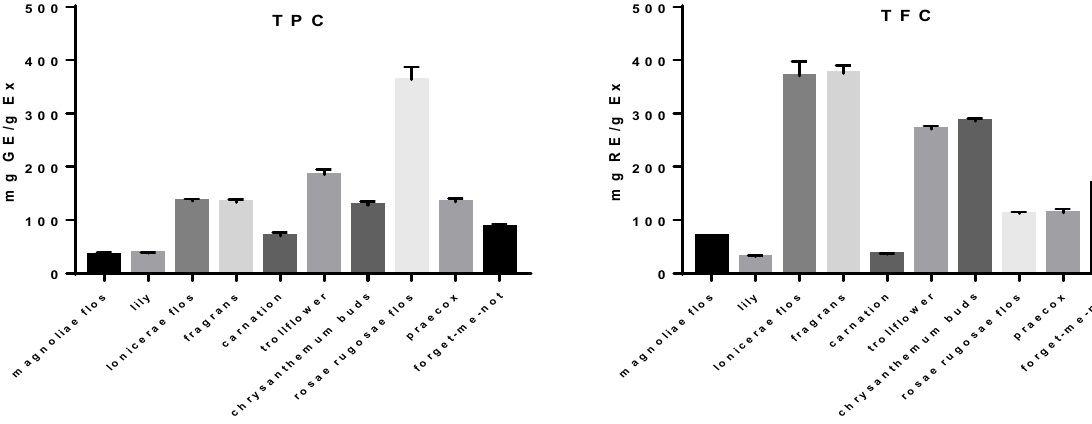
Figure 2: The TPCs and TFCs of ten flower